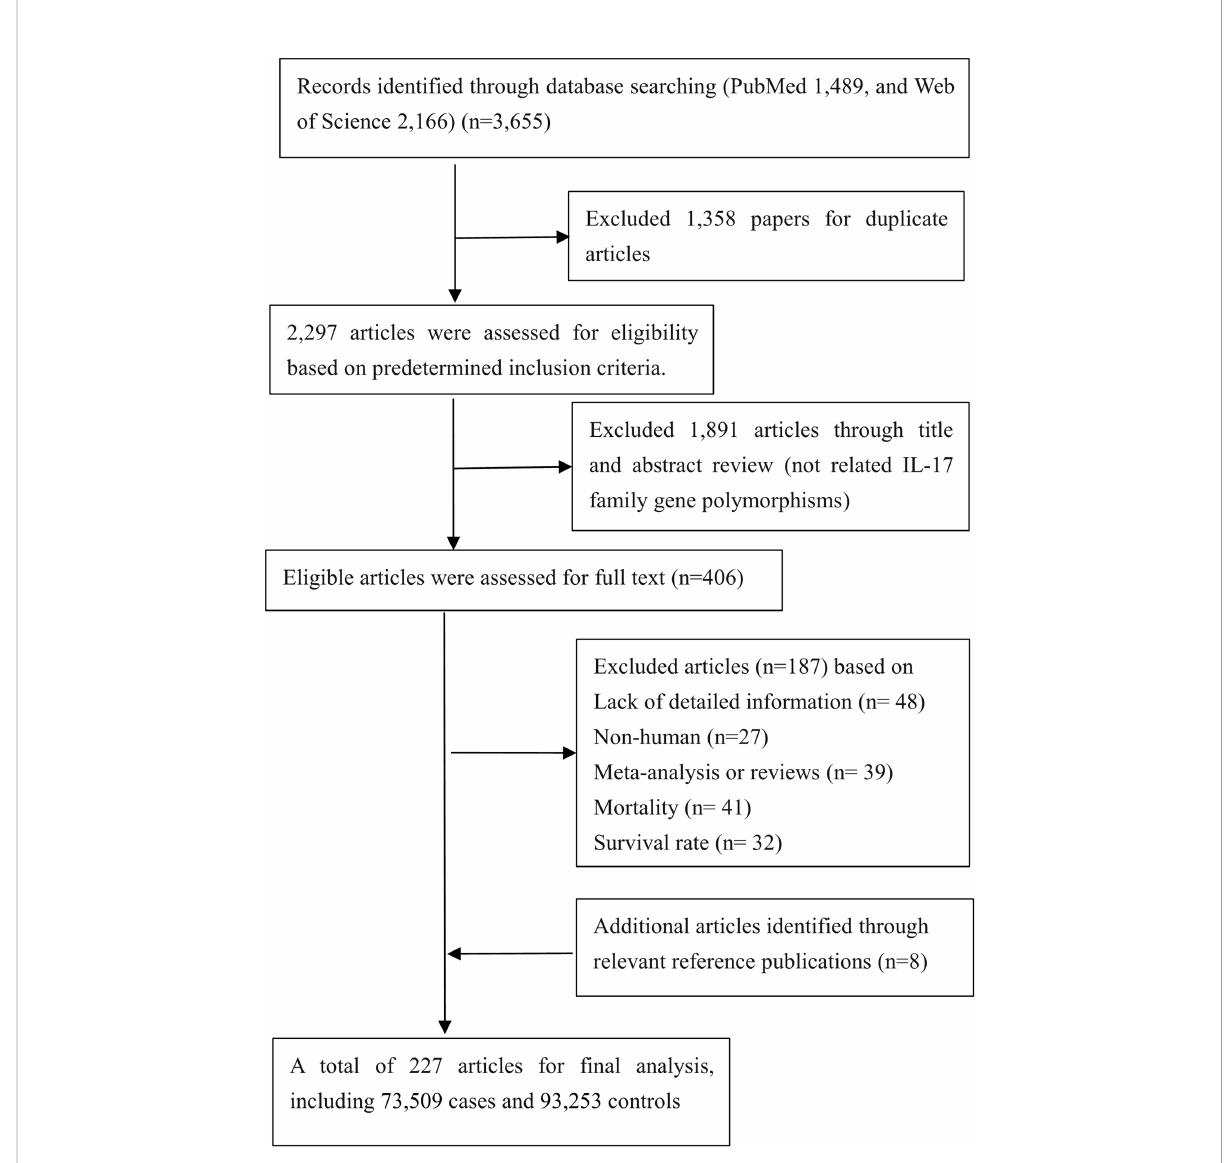
FIGURE 1 Flow diagram of search strategy and study